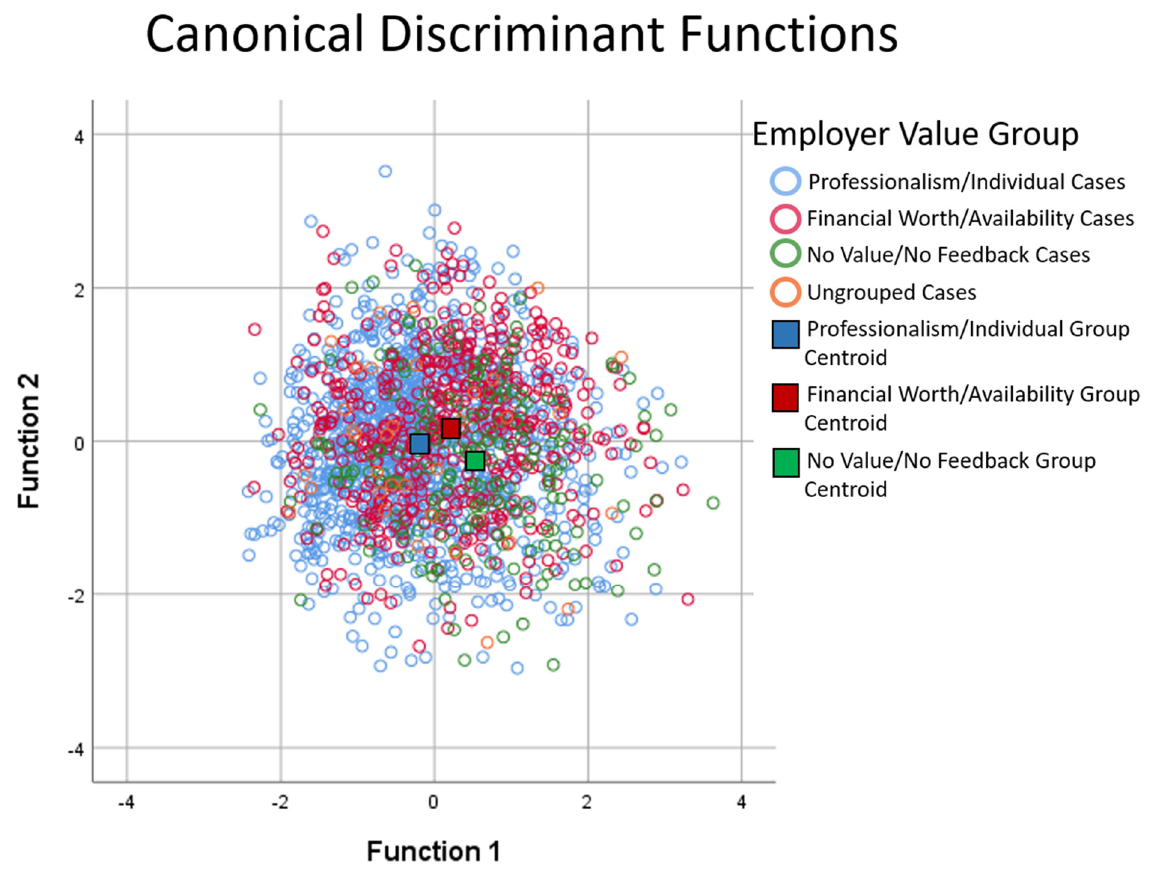
Figure 1. Canonical discriminant function graph showing discrimination between the three employer value groups (Professionalism/Individual; Financial Worth/Availability; No Value/No Feedback).